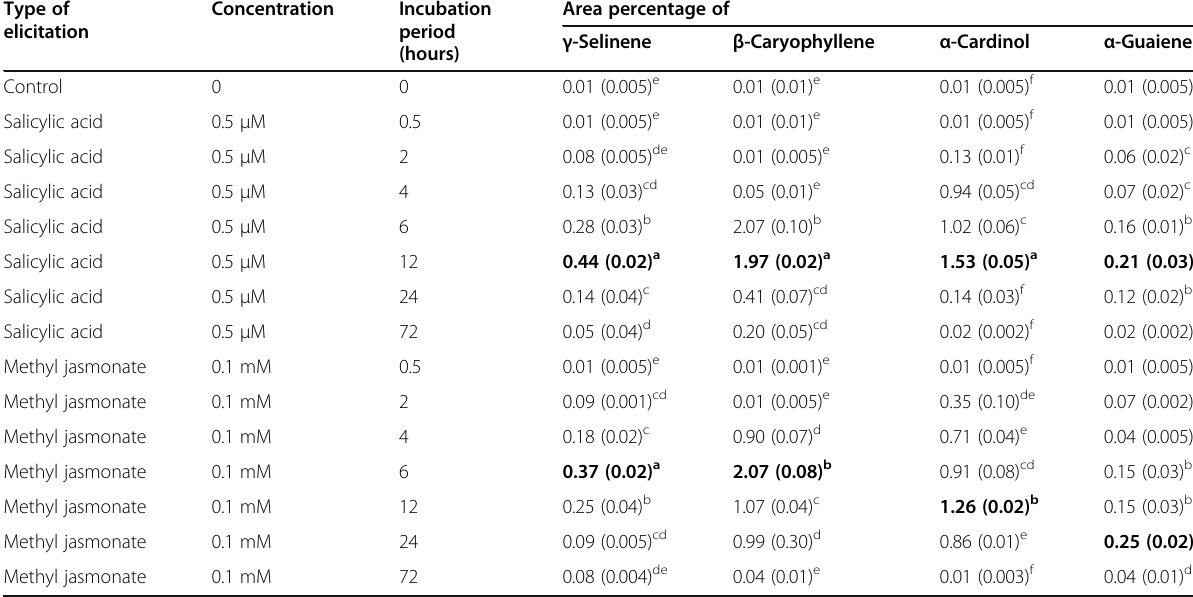
Table 2 Effect of Chemical elicitors on Gyrinops walla cell suspension Type of elicitation